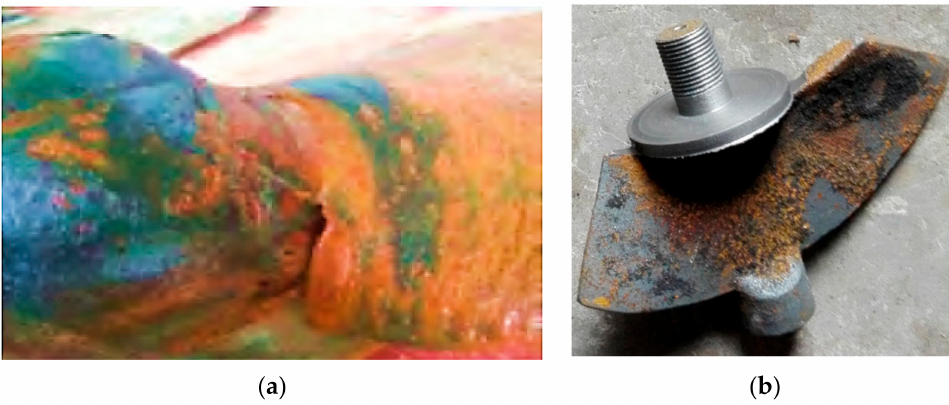
Figure 1. Erosion damage of the parts of a pump on site. ( a ) Impeller hub ( b )